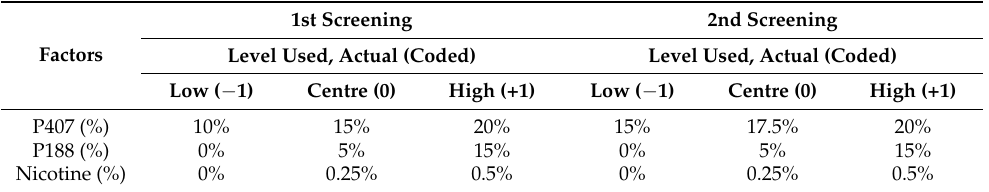
Table 8. Factorial design variables and experimental